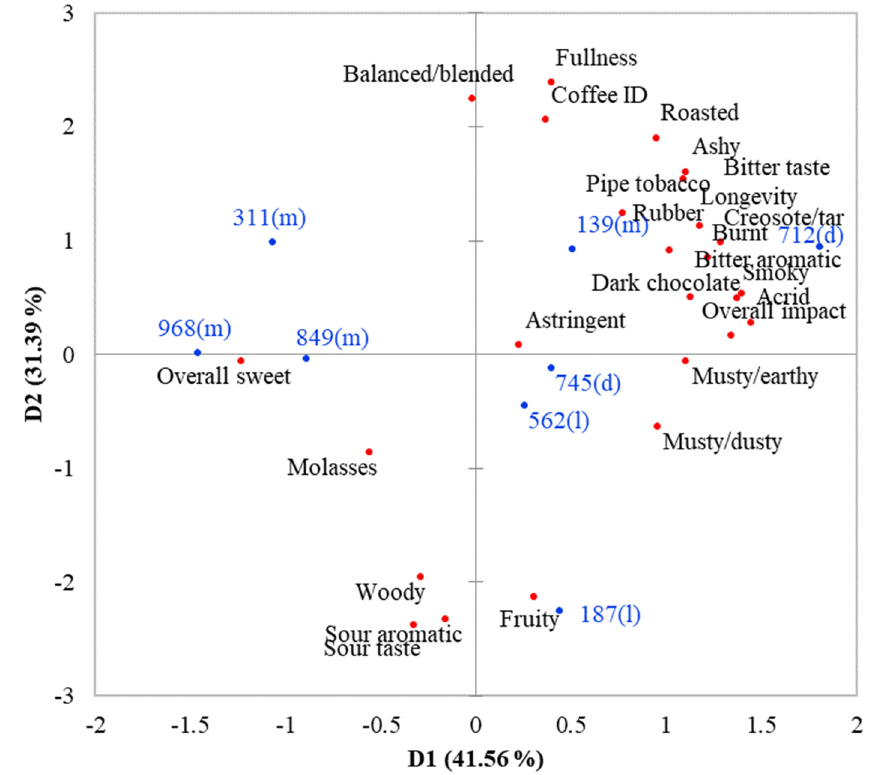
Figure 1. Principal component analysis (PCA) map of the sensory profiles of eight brewed black coffee. • = sensory attributes, • = samples with roast level in parenthesis (l = light, m = medium and d = dark).